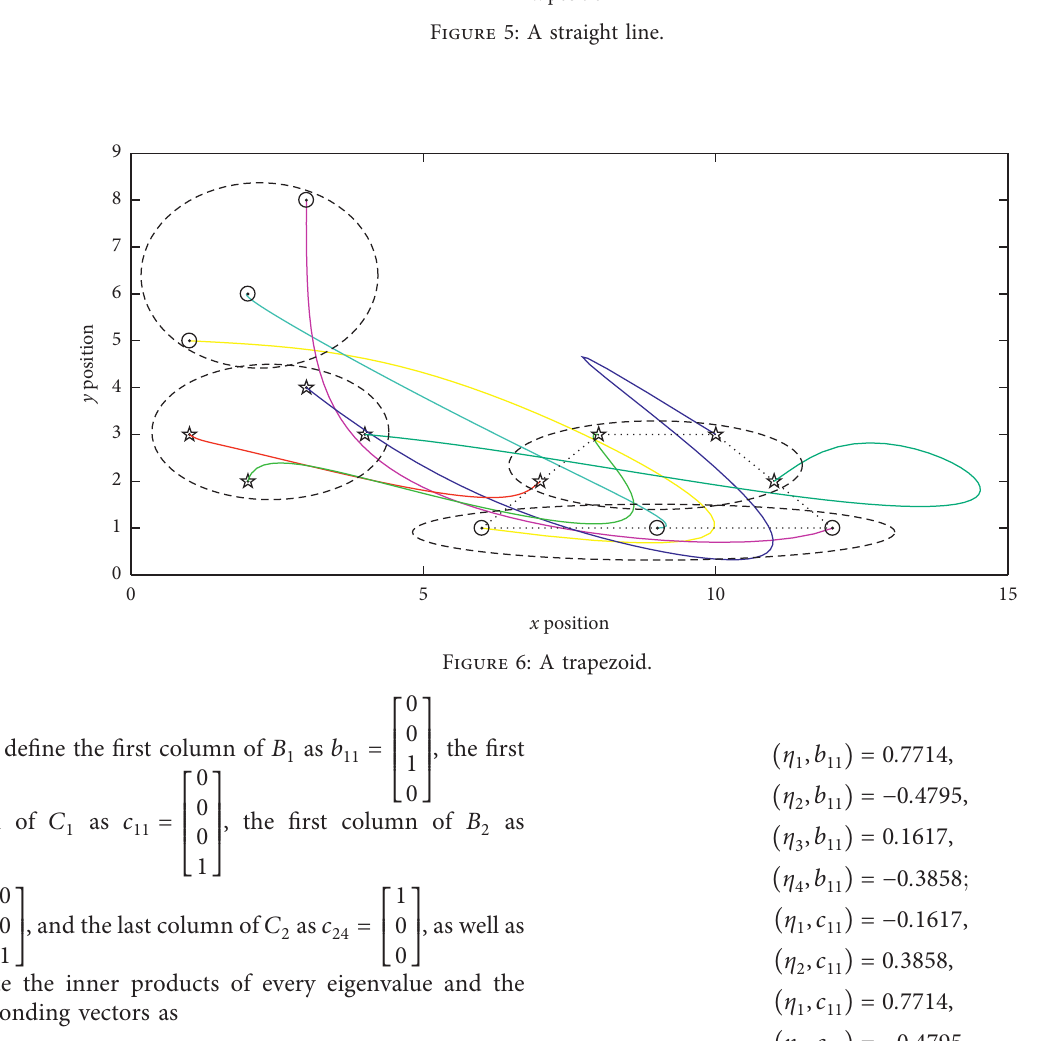
Figure 5: A straight line.